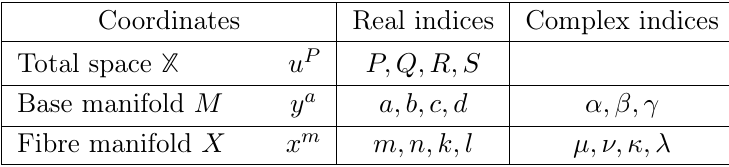
Table 1 . The coordinates and indices for the total space, fiber and base of the fibration X .